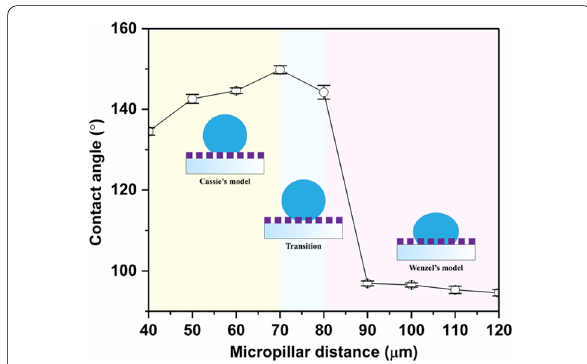
Fig. 4 J–V characteristics of the solar cell module with and without siloxane functionalized GO incorporated PUA composite film (S‑PG) superhydrophobic film with µ‑pillar distance of 70